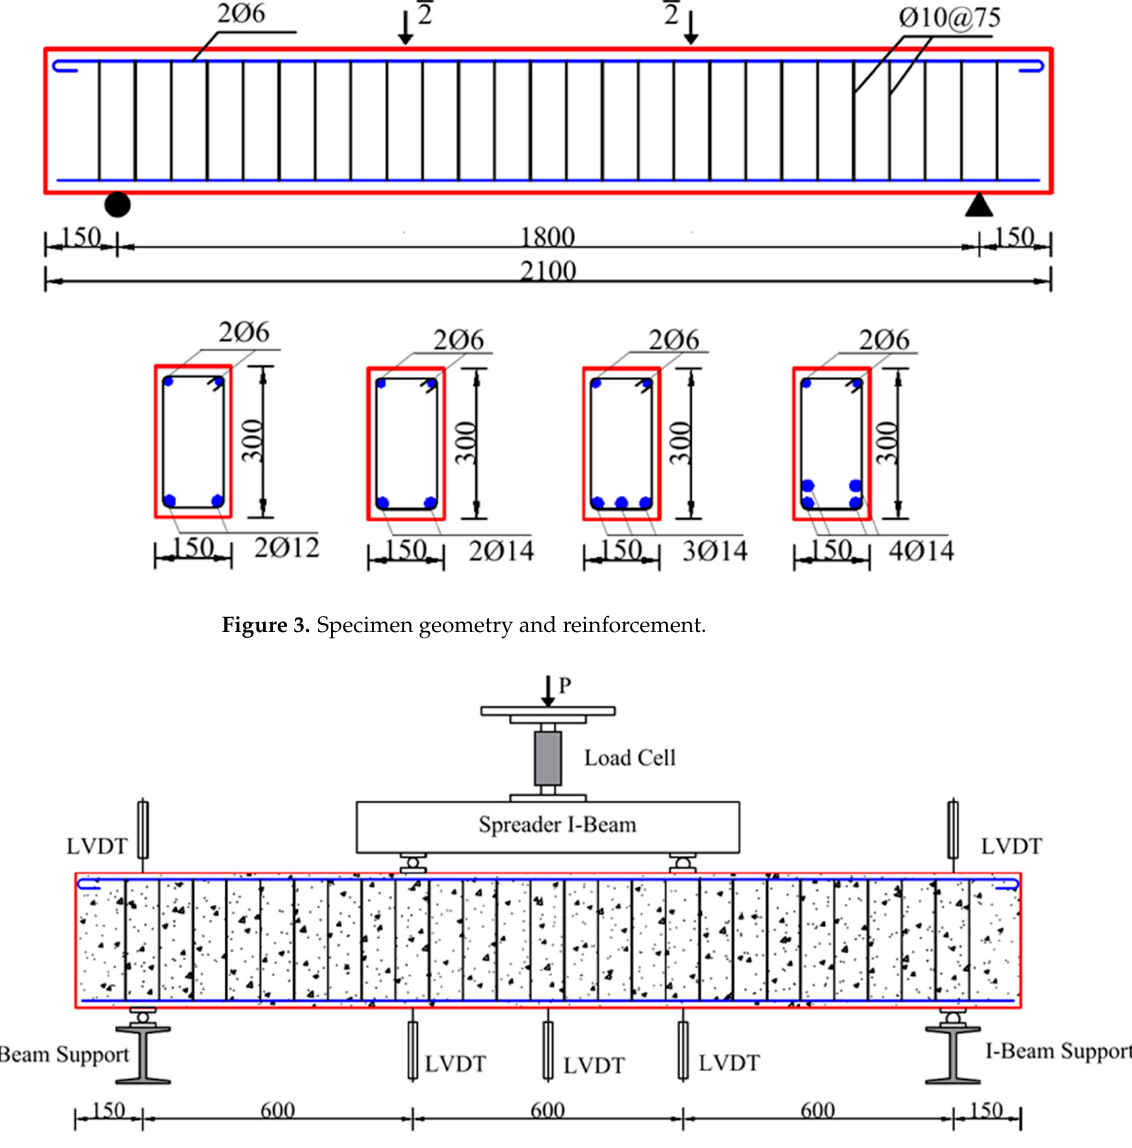
Figure 3. Specimen geometry and reinforcement.